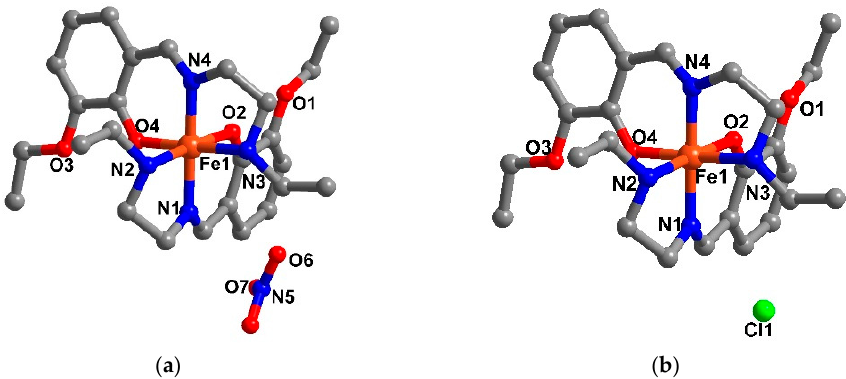
Figure 4. Representation of the asymmetric unit components for ( a ) 3 and ( b ) 4 . Hydrogen atoms are omitted for clarity.